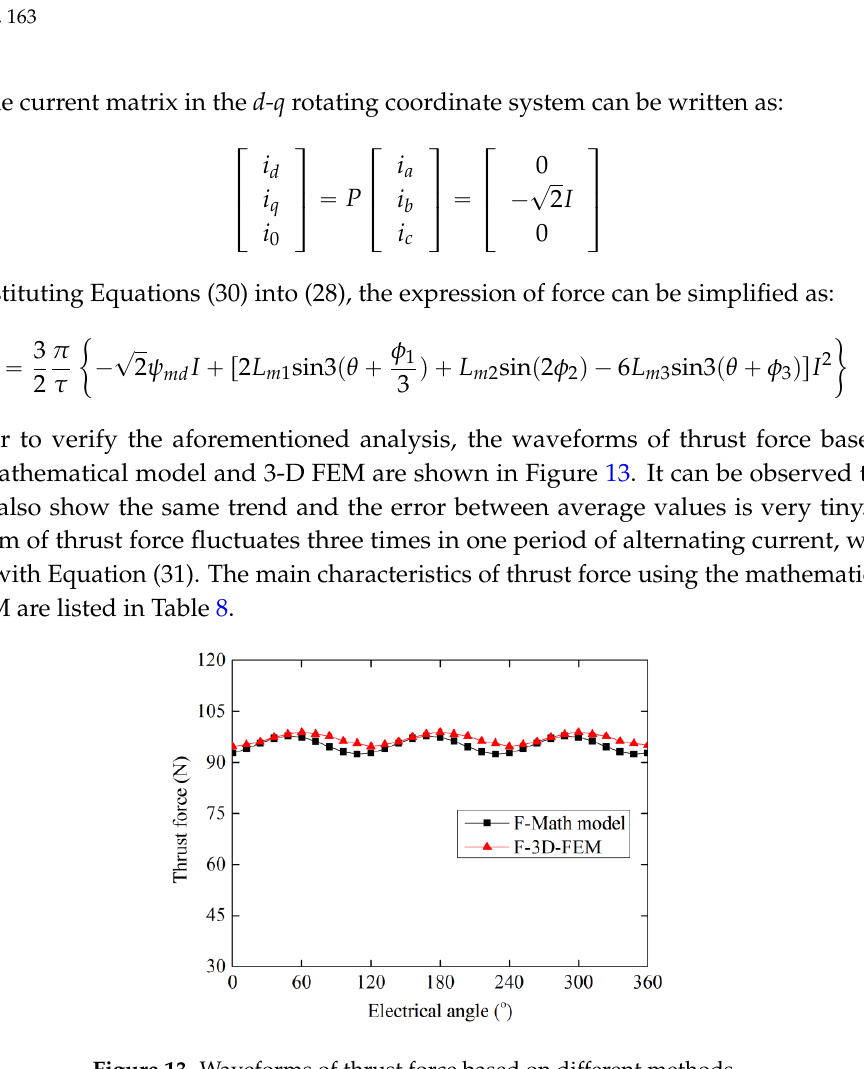
Figure 13. Waveforms of thrust force based on different methods. Table 8. Characteristic of thrust force based on different